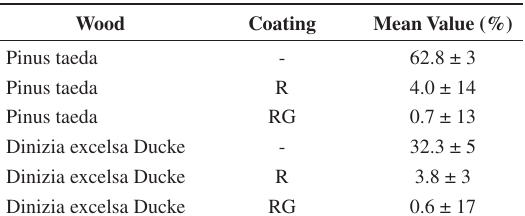
Table 6. Percentage of water absorbed in uncoated and coated samples. Wood